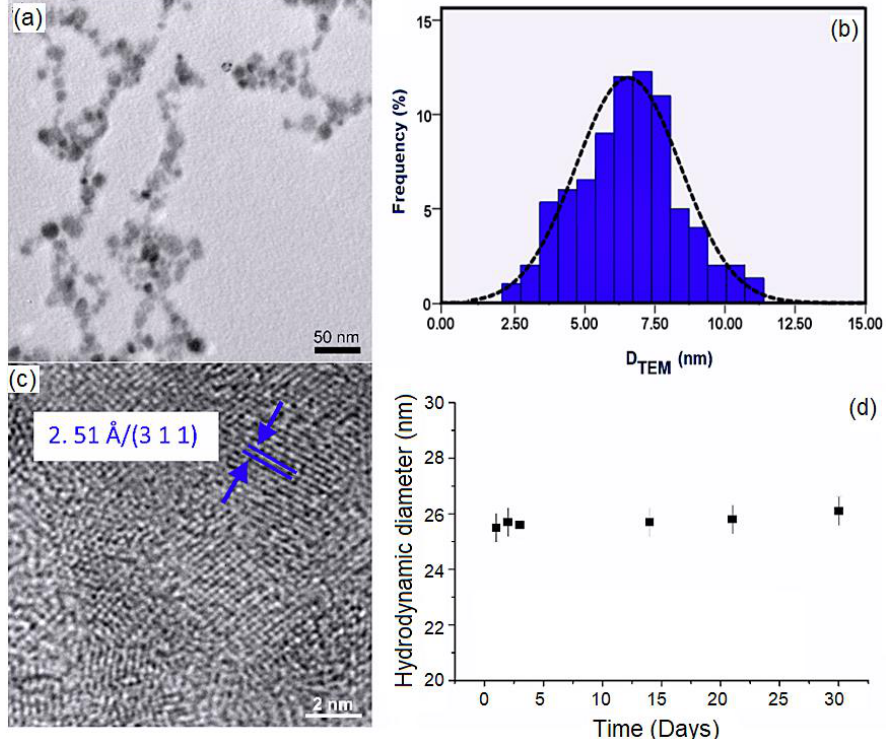
Figure 1. TEM image ( a ), size distribution histogram ( b ), HRTEM image ( c ) and average hydrody- namic diameter of the DIO-AMF nanoparticles as a function of time ( d ).